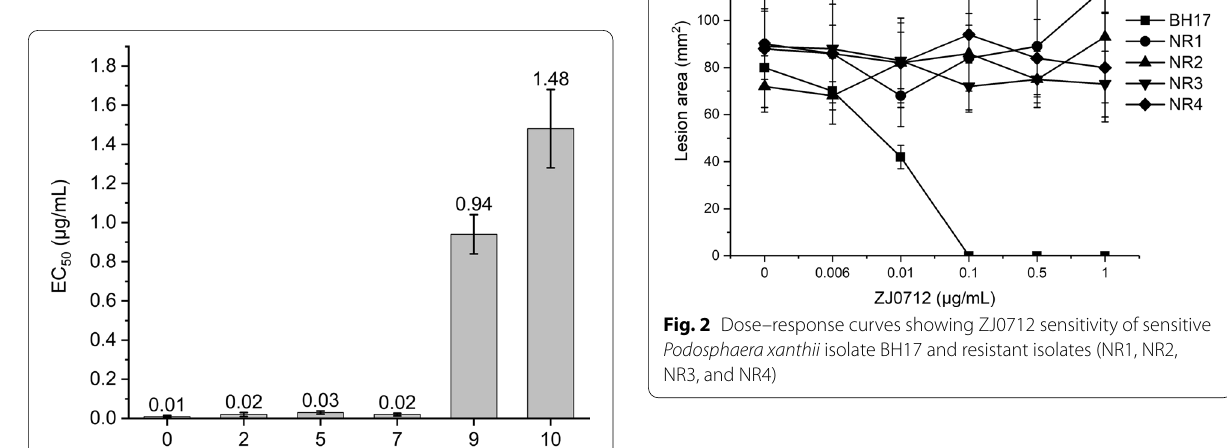
(Table 2). All seven ZJ0712-resistant isolates showed sim- ilar pathogenicity to that of the wild-type isolate BH17 (Table 2).